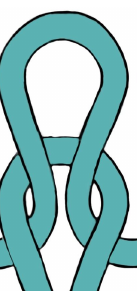
Figure 1. A single stitch, with its “legs” holding the “head” (upper loop) of the stitch below.